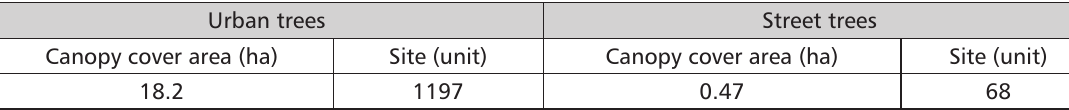
Canopy cover area of street and urban woody plants